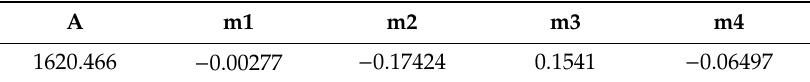
Table 2. Hensel-Spittel parameters of